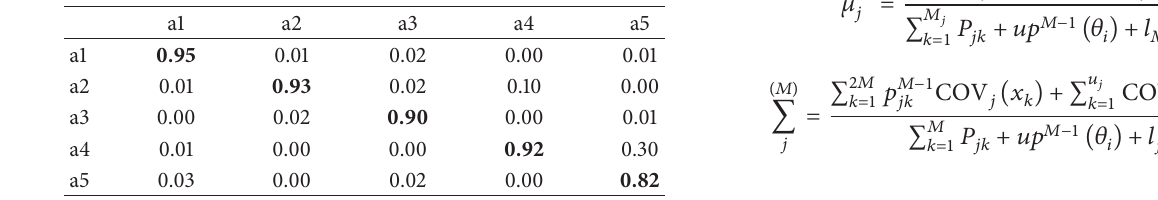
Table 1: Confusion matrix for KTH